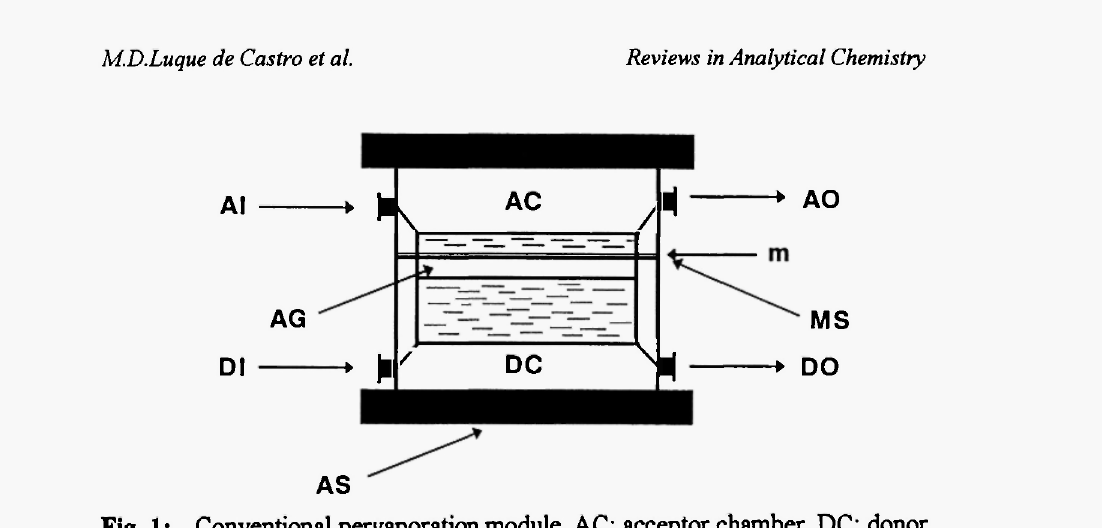
Fig. 1: Conventional pervaporation module. AC: acceptor chamber, DC: donor chamber, MS: membrane support, m: membrane, AG: air gap,